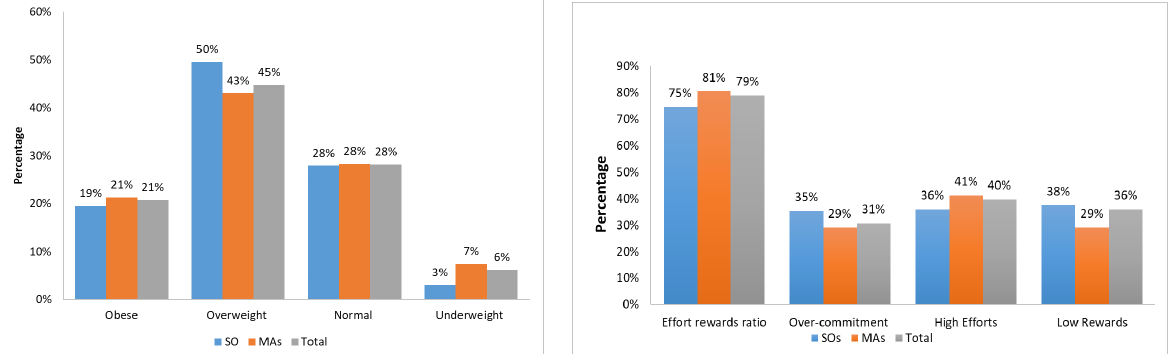
Figure 4. Prevalence of overweight and obesity in the sample